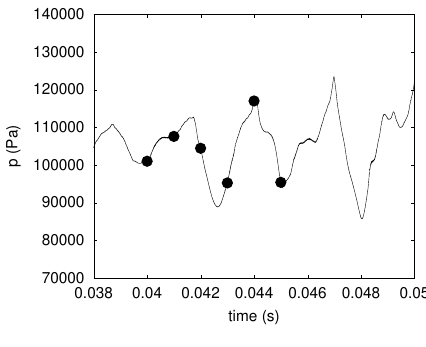
Figure 3. Time trace of the pressure.